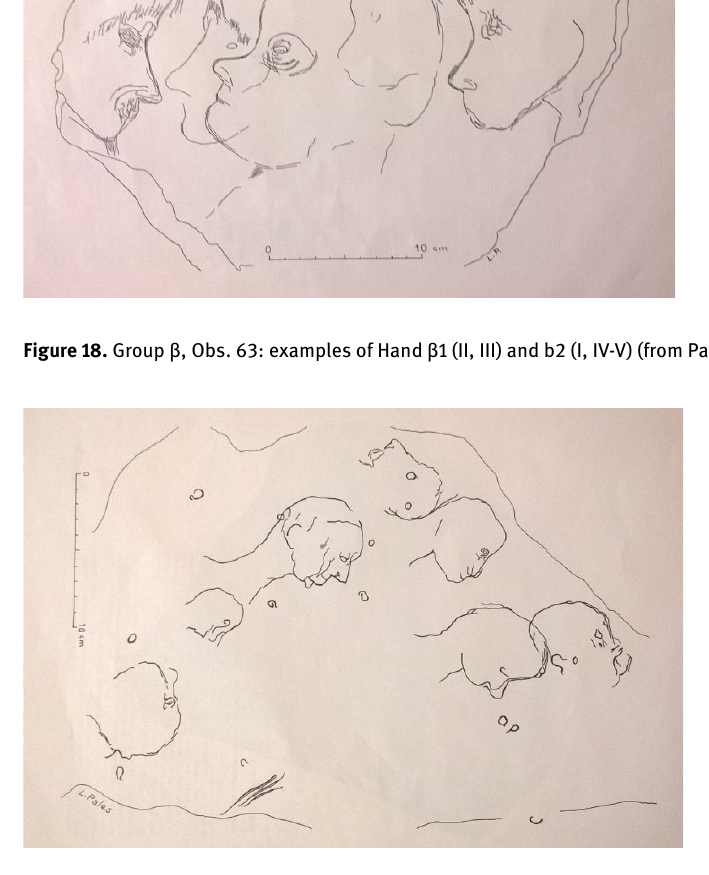
Figure 19. Group β, examples of Hand β3: Obs. 28(I-VII) (from Pales,